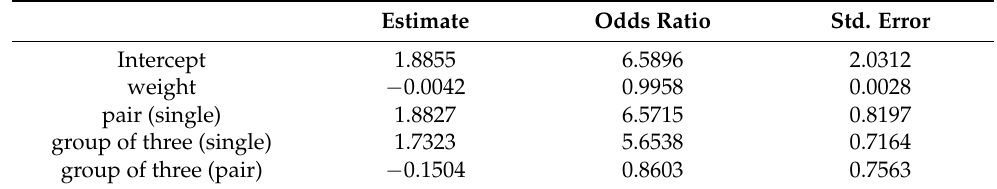
Table 2. Table of coefficients for the logistic regression model with lesions of kits as dependent variable.